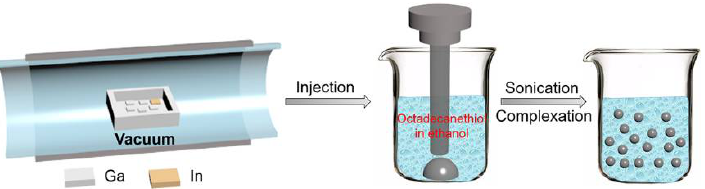
Figure 1. Schematic illustration of the fabrication process of eutectic GaIn (eGaIn) nanodroplets.